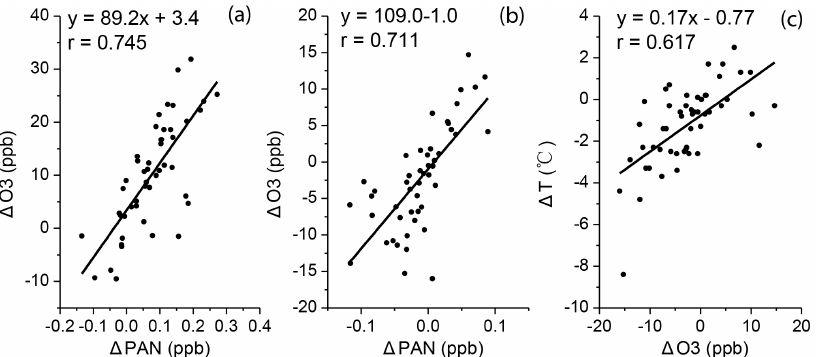
Figure 3. Scatter plots of (cid:49) PAN (variation of the PAN concentration), (cid:49) O 3 (variation of the O 3 concentration) and (cid:49)T (variation of temperature) in specific time spans: (a) from 05:00 to 09:00LT; (b, c) from 02:00 to 04:00LT. All correlations shown in the figures are statistically significant at α =